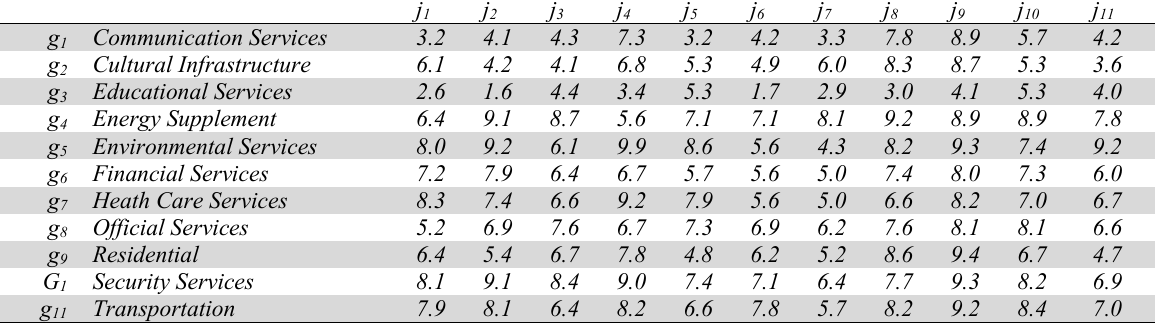
Mean of expert opinion for the impact of infrastructures investment opportunities in in realization of investment opportunities